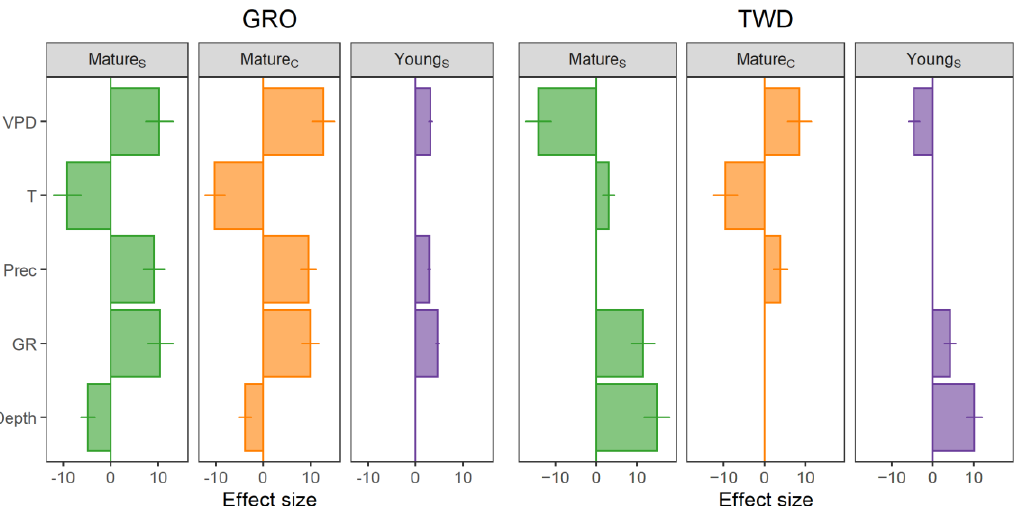
Figure 5. Effect sizes of environmental variables on monthly growth rate (GRO) and monthly tree water deficit indicator (TWD) derived from GLMM models (see Table S2). Depth — average monthly water table depth, GR — average monthly global radiation, Prec — monthly sum of precipitation, T — average monthly temperature, VPD — average monthly vapor pressure deficit.